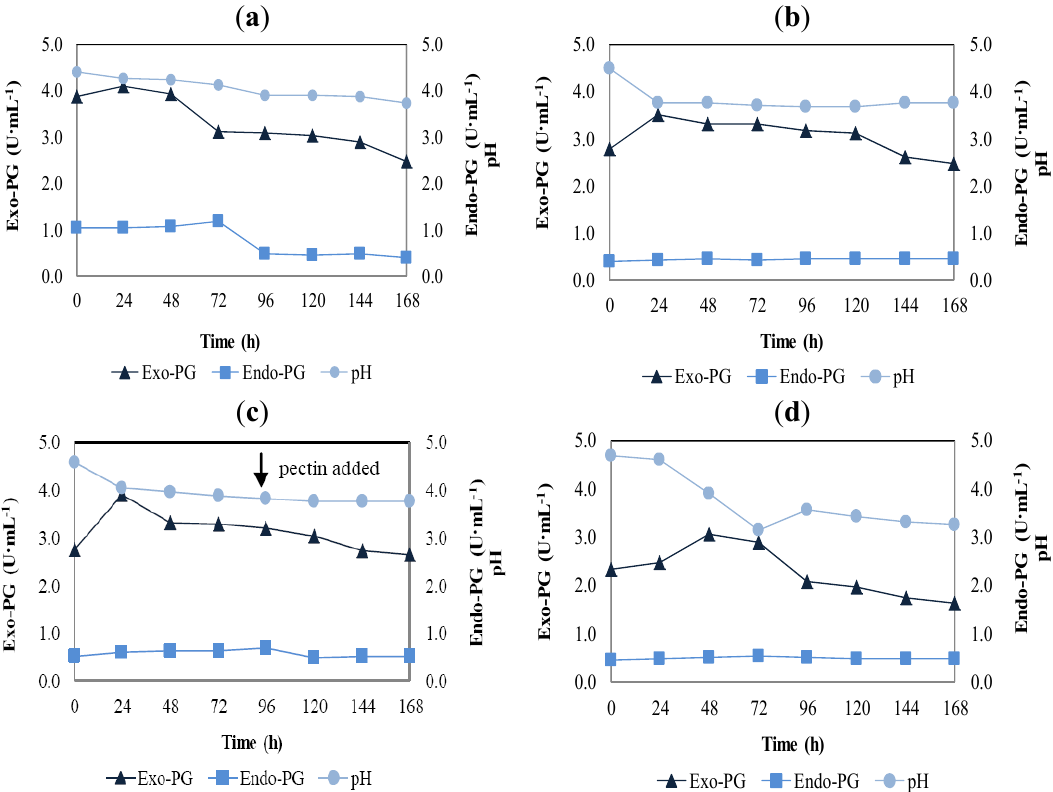
Figure 2. Production of exo-polygalacturonase ( ▲ ) and endo-polygalacturonase ( ■ ) by Aspergillus niger strain URM 5162 in fixed bed reactor. ( a ) immobilised cells without aeration; ( b ) immobilised cells with aeration; ( c ) immobilised cells with aeration and adding pectin; and ( d ) free cells with aeration. pH variation during the polygalacturonases production ( ●